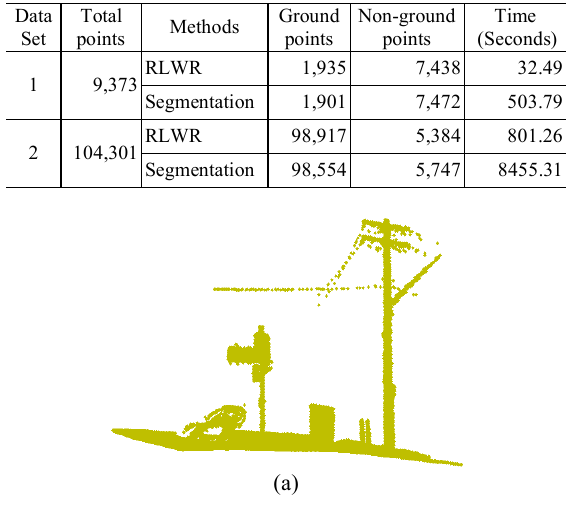
Figure 6. Dataset 3, Ground and non-ground surface points from the proposed algorithm (a) front view (b) back